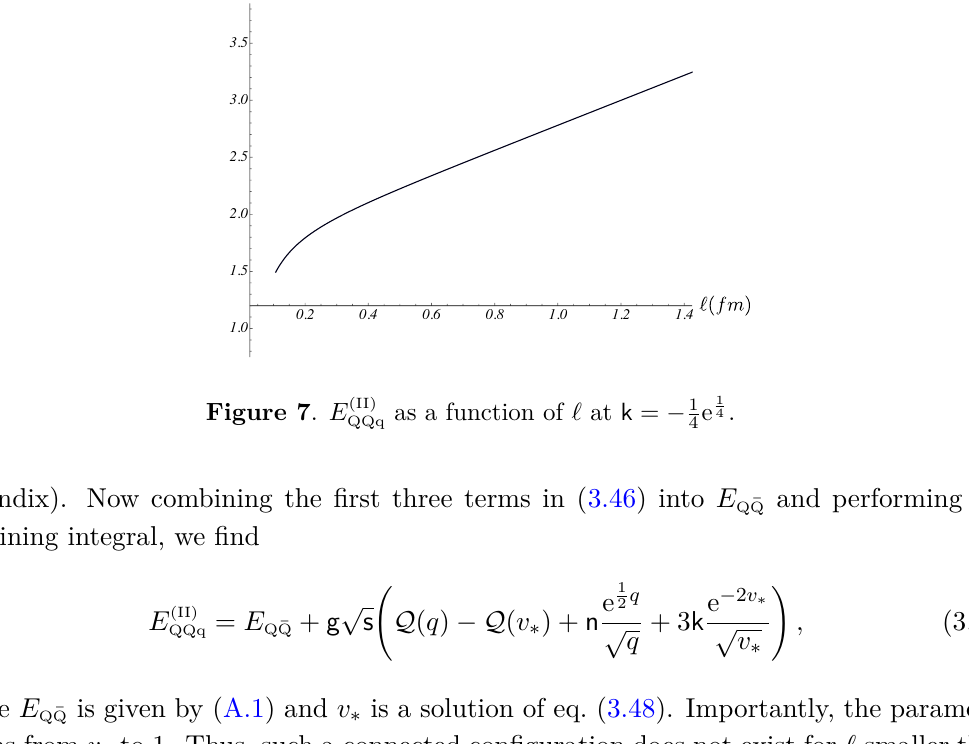
as a function of ‘ at k = − 1 QQq